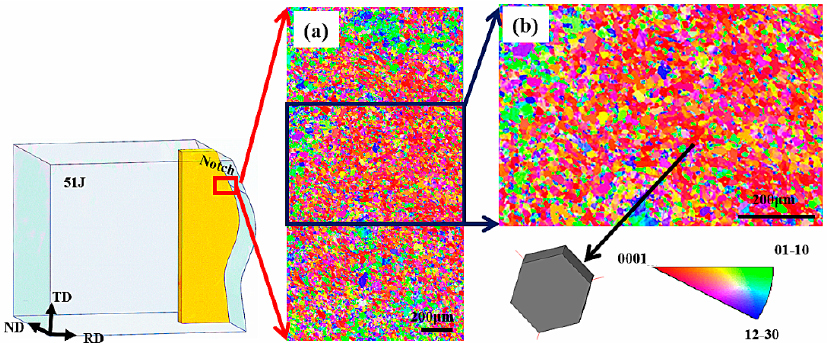
Figure 11. ( a ) Representative inverse pole figure (IPF) maps of the RD-TD specimen (IPF//ND); ( b ) enlarged view of the black box marked in ( a ).